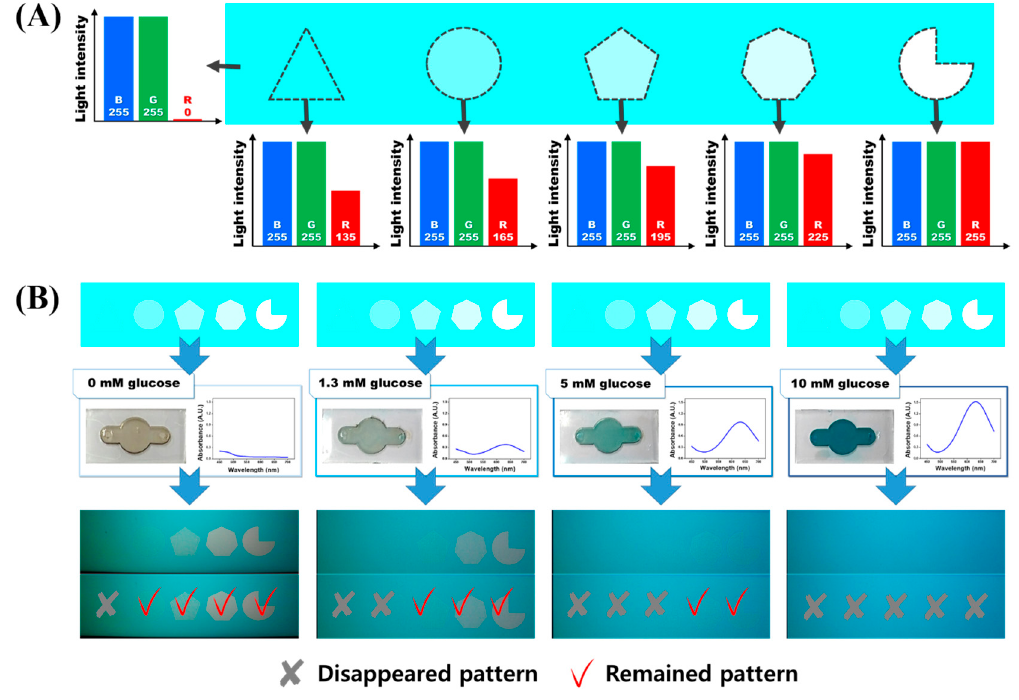
Figure 3. Fabrication of the signal guides on the LED display including the various intensity of red light: ( A ) The signal guides have a fixed intensity of blue and green light with varying intensity of red light, and the surrounding area contains blue and green of fixed intensity; and ( B ) the images of a signal guide during superposition of a biosensing channel. The numbers of signal guides change according to the chromogen concentration.